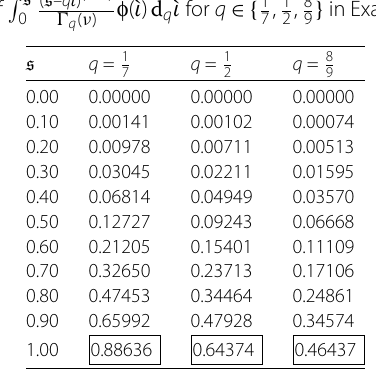
Table 5 Numerical results of